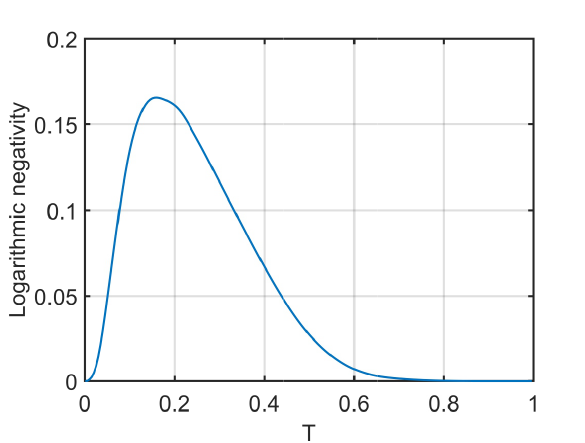
Figure 4: Non-monotonic behavior of the entanglement with temperature at the point I = J = − 0.4 near the low-temperature sharp peak ( K = − 1). See also Fig. 3(a).